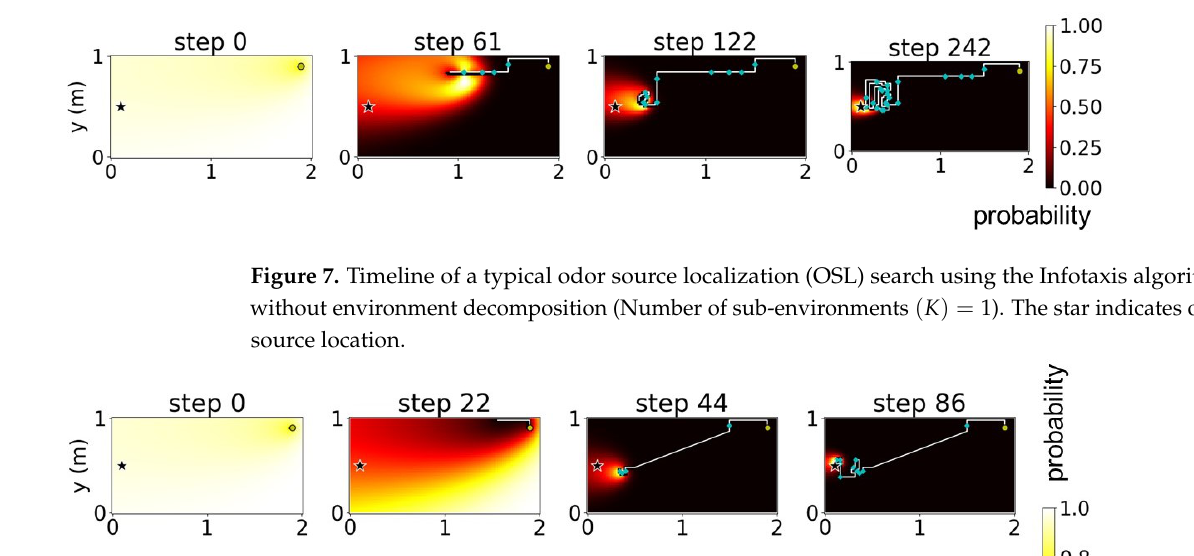
Figure 6. Plume profile for testing based on the airflow direction. The star indicates odor source location.